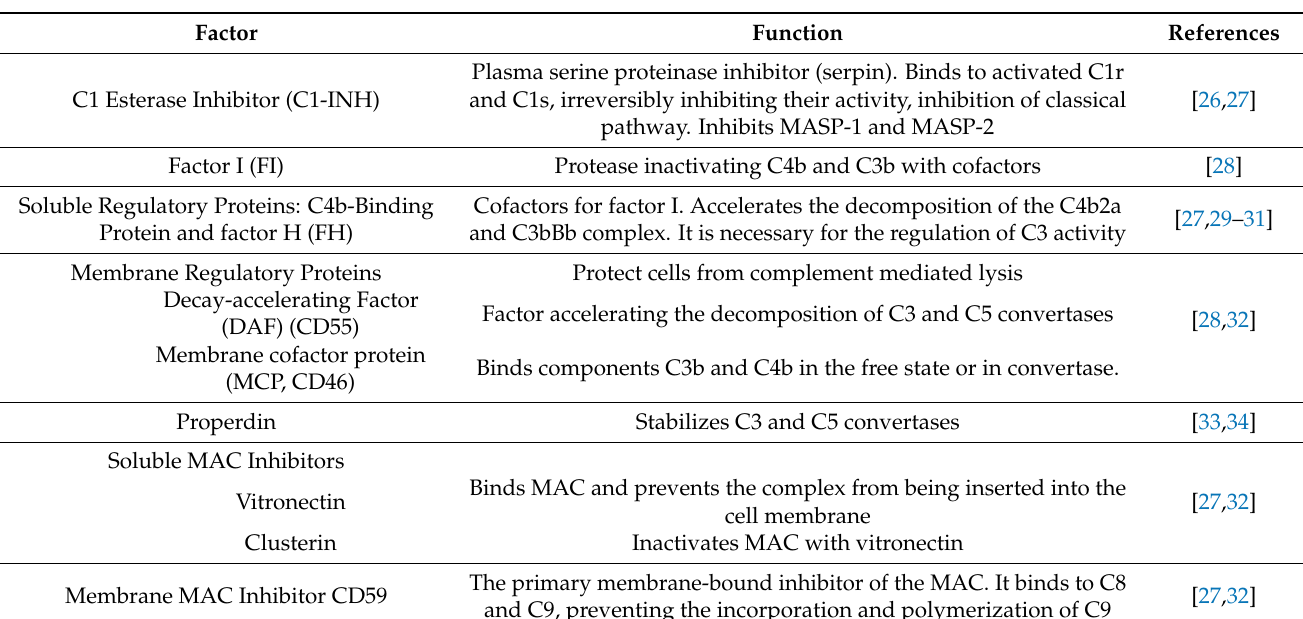
Table 1. Factors regulating the activity of the